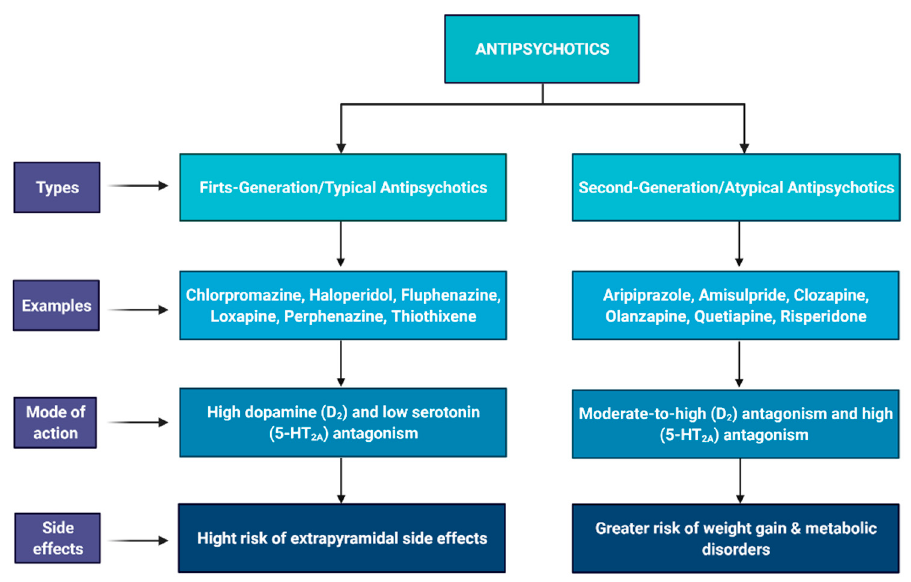
Figure 4. Types, mechanism of action, and side effects of first-generation and second-generation antipsychotics.